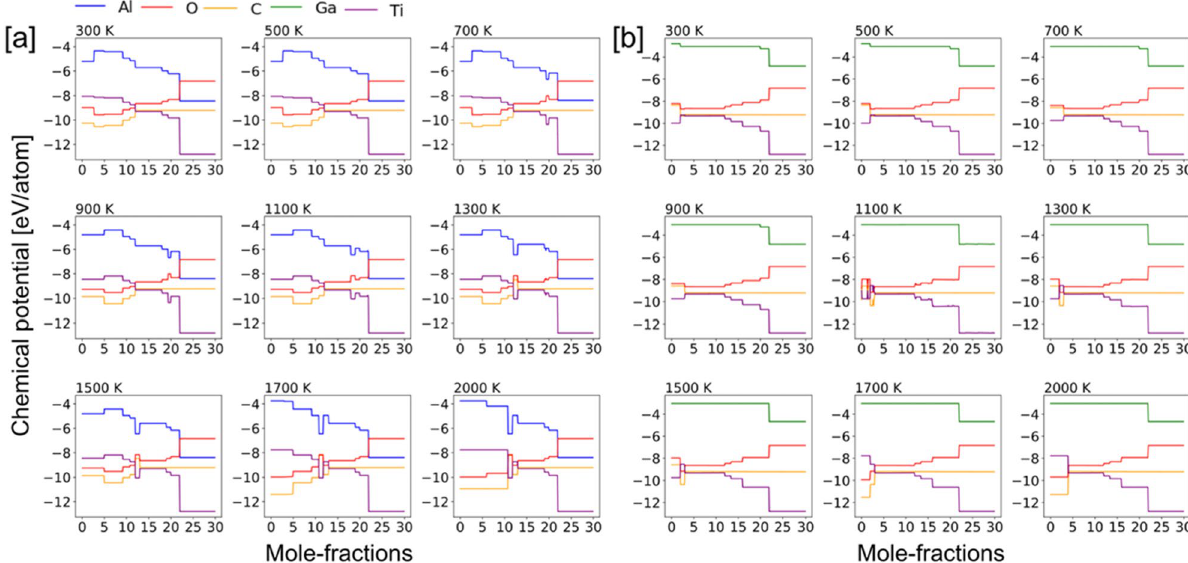
Figure 6. Oxidation reaction chain showing change in chemical potential of ( a ) [Ti 2 AlC + O 2 ] and ( b ) [Ti